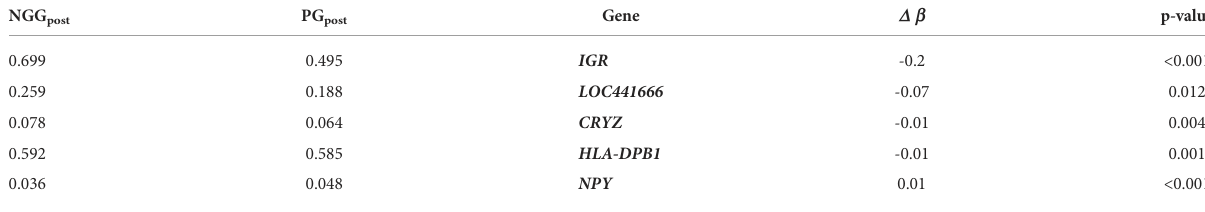
TABLE 5 Differentially Methylated Regions (DMRs) of the Prediabetes Group (PG) compared to the Normal Glucose Group (NGG) before 14 weeks of physical activity intervention. NGG post PG post